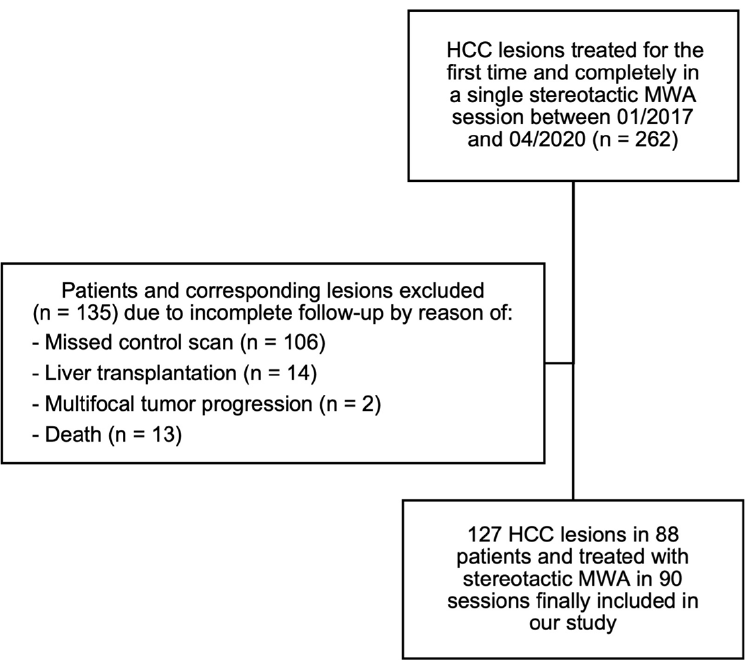
Figure 1. Flowchart of HCC lesion identification using in-/exclusion criteria for the final analysis of minimal ablative margin and maximum tumor diameter.